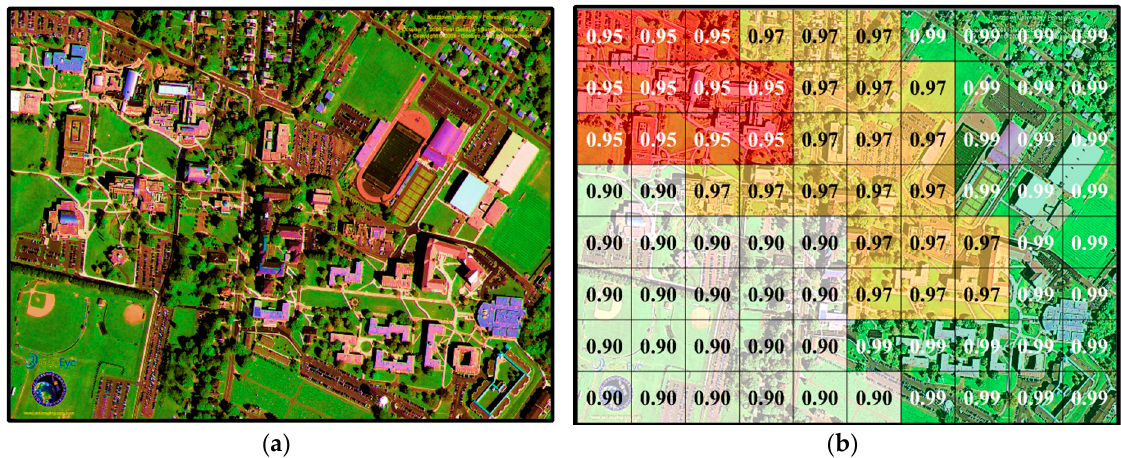
Figure 6. Grid based Spatiotemporal Impact as Risk Profile. ( a ) Network Area; and ( b ) Grid Model.